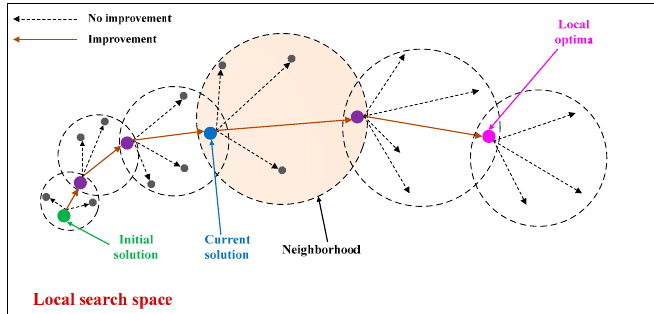
Figure 1. Sketch map of the Gaussian local search strategy.